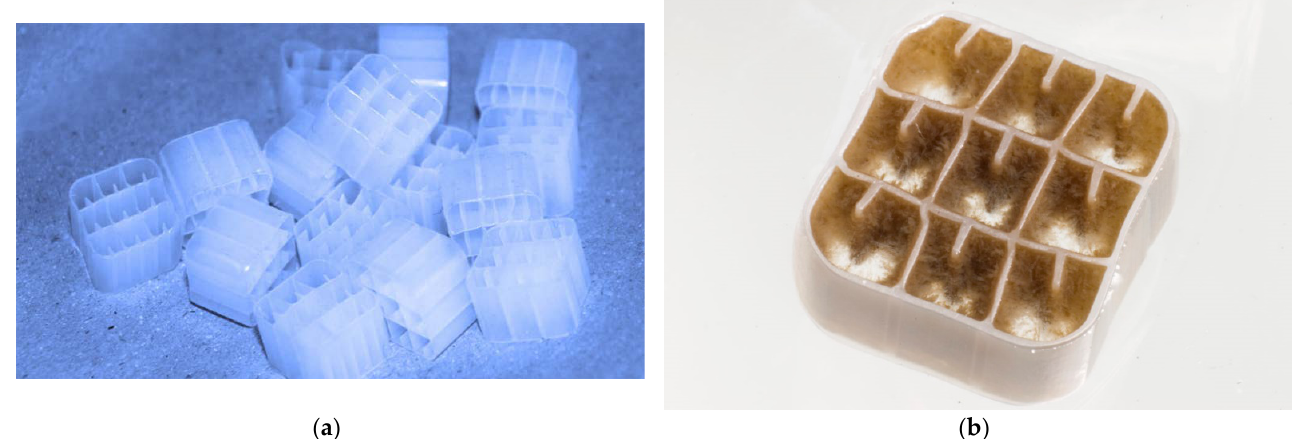
Figure 4. BWTX ® carrier without biofilm growth ( a ) and with matured biofilm growth ( b ).